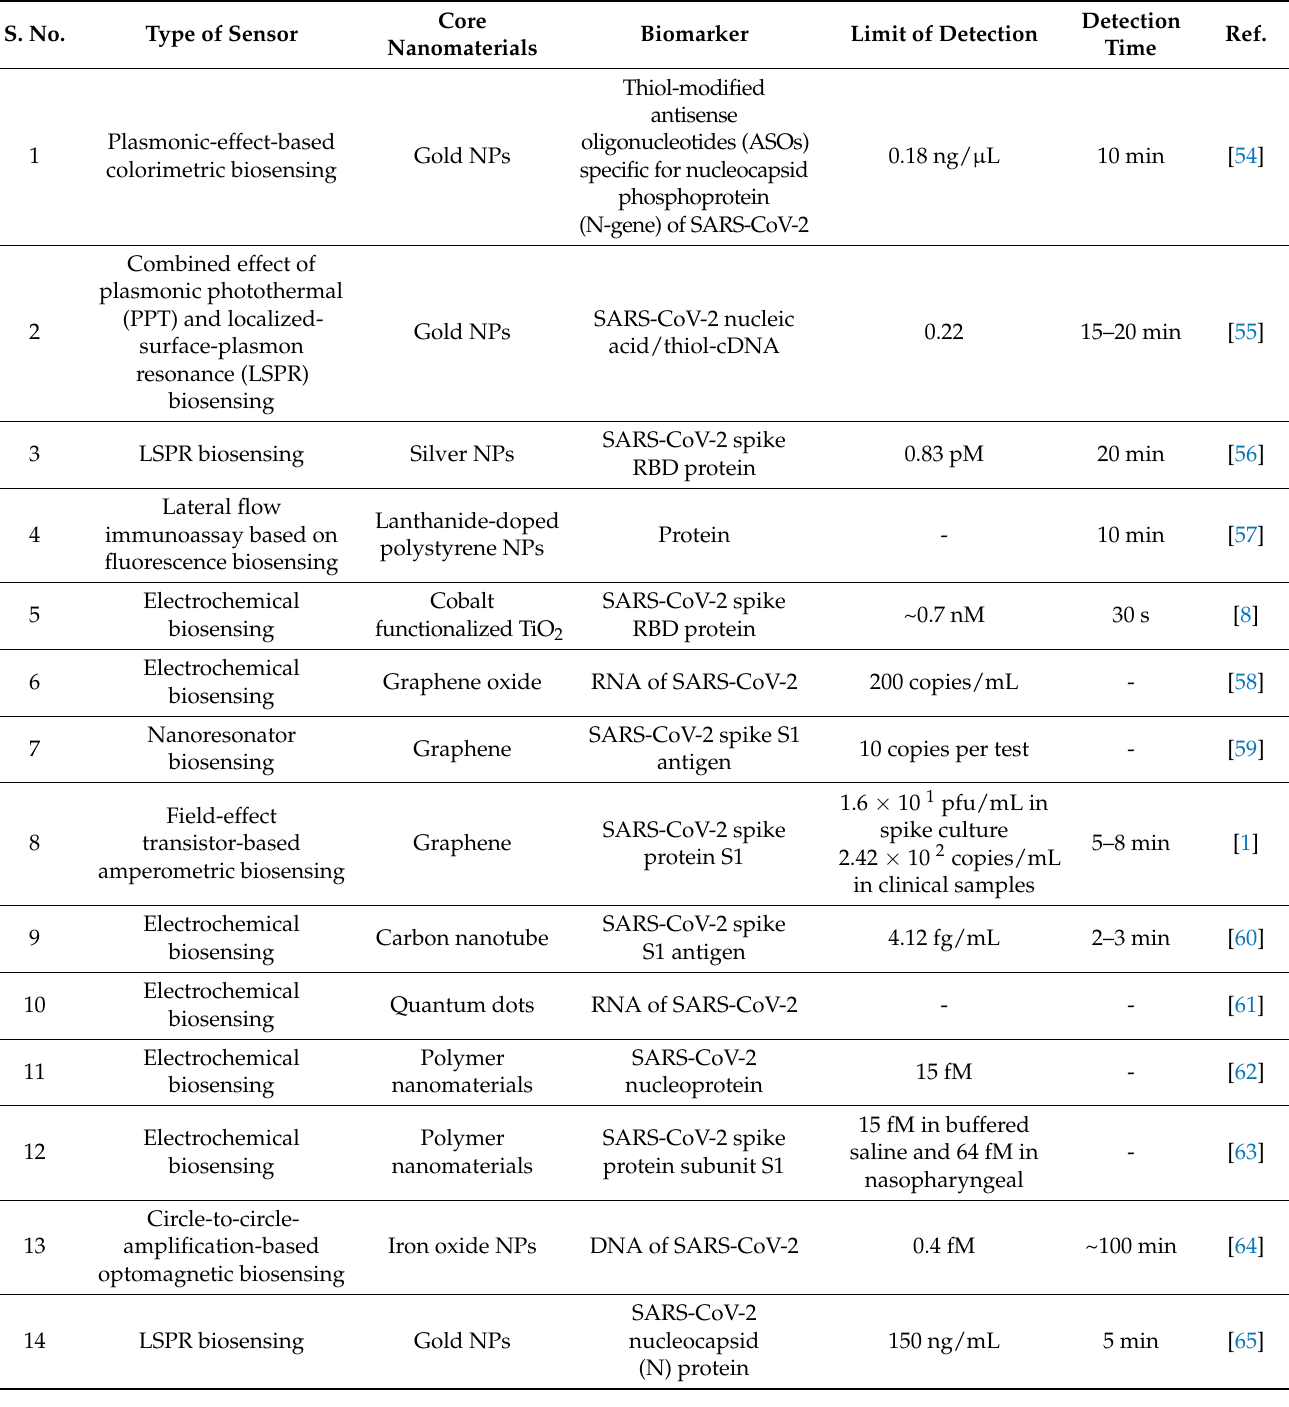
Table 1. Characteristics of nanobiosensors for detection of SARS-CoV-2